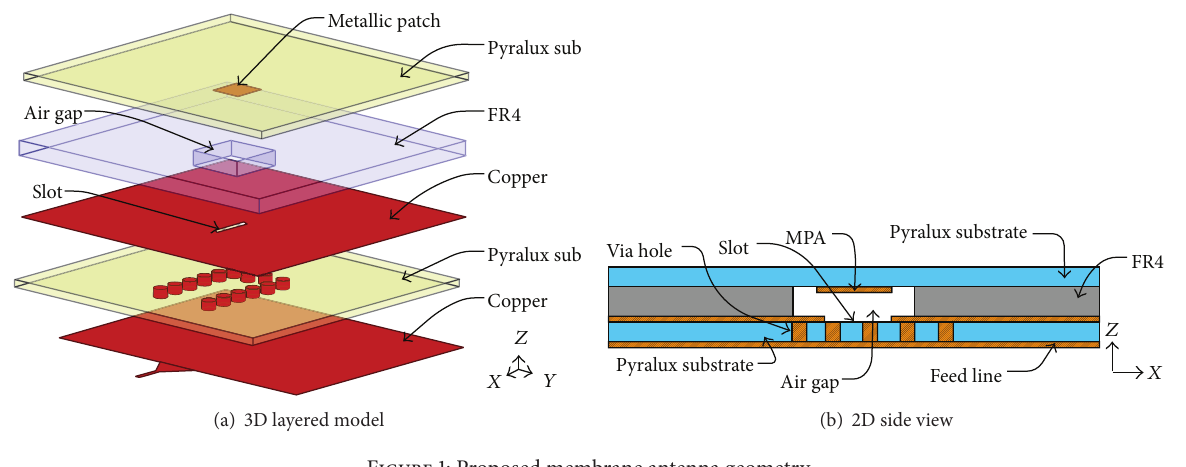
Figure 1: Proposed membrane antenna geometry.